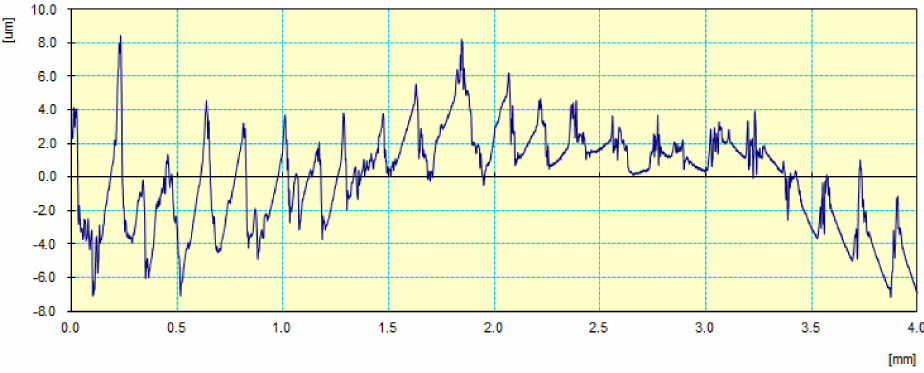
Figure 3. Surface roughness profile (I p , V g , T on , T off , P) = (5, 70, 200, 20, 19); units as per Table